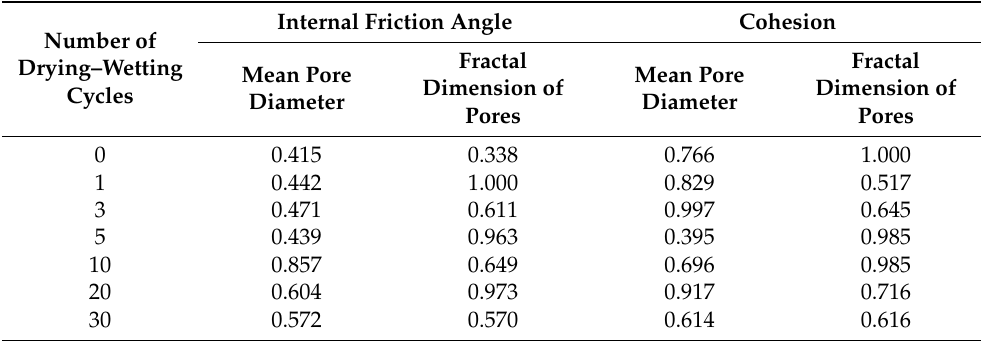
Table 11. Calculated correlation coefficients between shear strength parameters and microstructural parameters of Yili loess samples under drying–wetting cyclic action. Number of